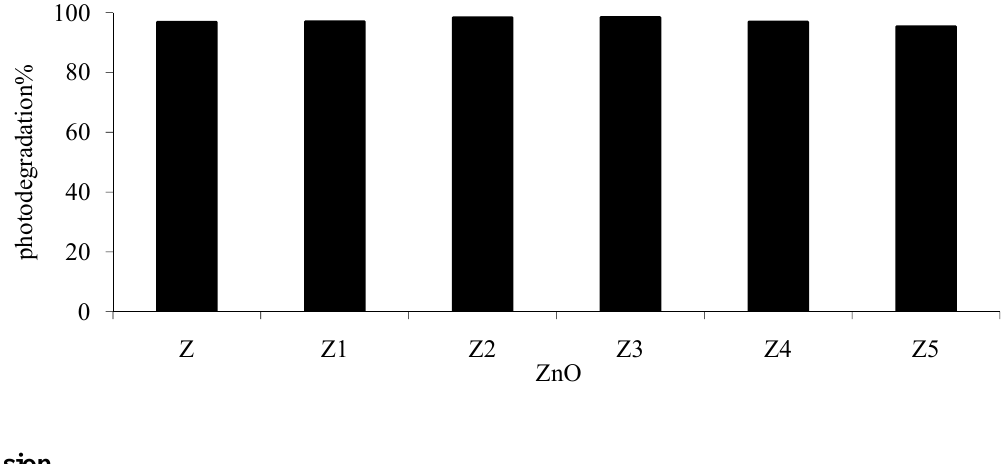
Figure 10. Reusability of ZnO in photodegrading p -cresol solution under UV. Z is fresh ZnO cycle and Z1, Z2, Z3, Z4 and Z5 are reused ZnO cycle. Initial condition; concentration of p -cresol = 100 ppm, ZnO concentration = 2.5 g/L, pH = 7.49, irradiation time = 6